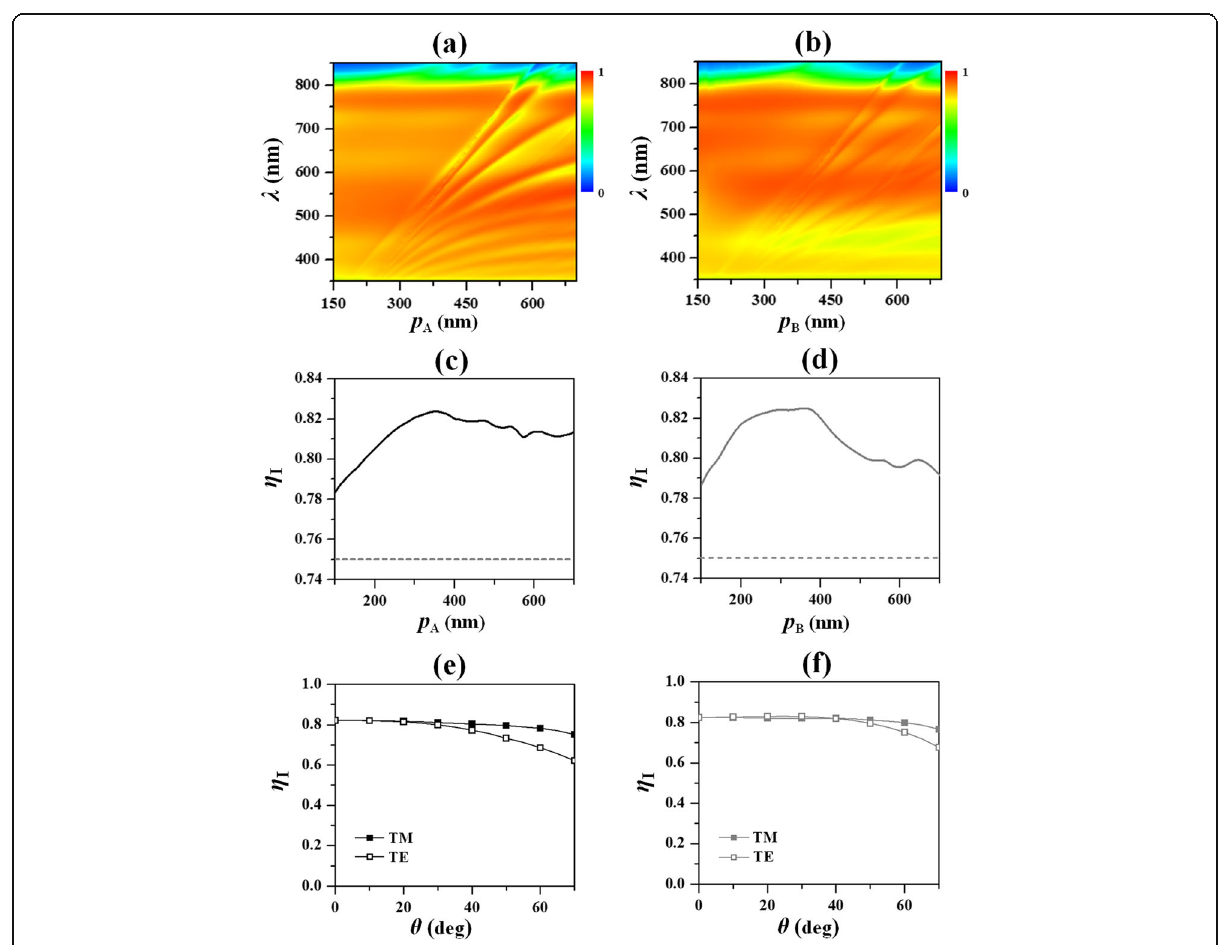
Fig. 5 a , b The absorption spectra when the periodicities of the PME patterns are tuned at normal incidence for Device A ( a ) and Device B ( b ). The integrated absorption efficiency in the active layer ( η I ) versus the periodicity for Device A ( c ) and Device B ( d ) with the dashed line representing η I for the control device. η I versus the incident angle θ at TM or TE polarization for the optimal Device A ( e ) and Device B ( f